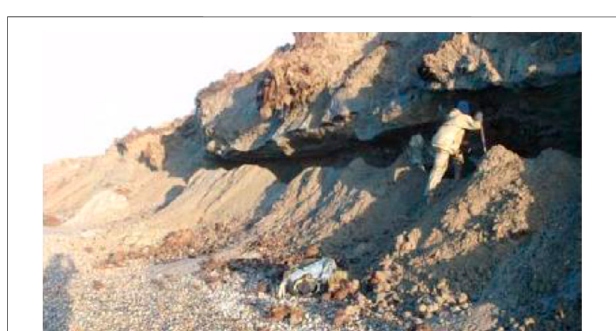
FIGURE 5 | Photo showing material that has slumped onto the beach face following bluff face thaw at Barter Island (2011 image courtesy of Li Erikson, U.S. Geological Survey). The bluff height is about 10 m and the sediment areal density is about 600 g/cm 2 , based on USGS data. Interestingly, the photo was taken soon after the 2008 niche erosion/block collapse event and the niche is still in evidence.